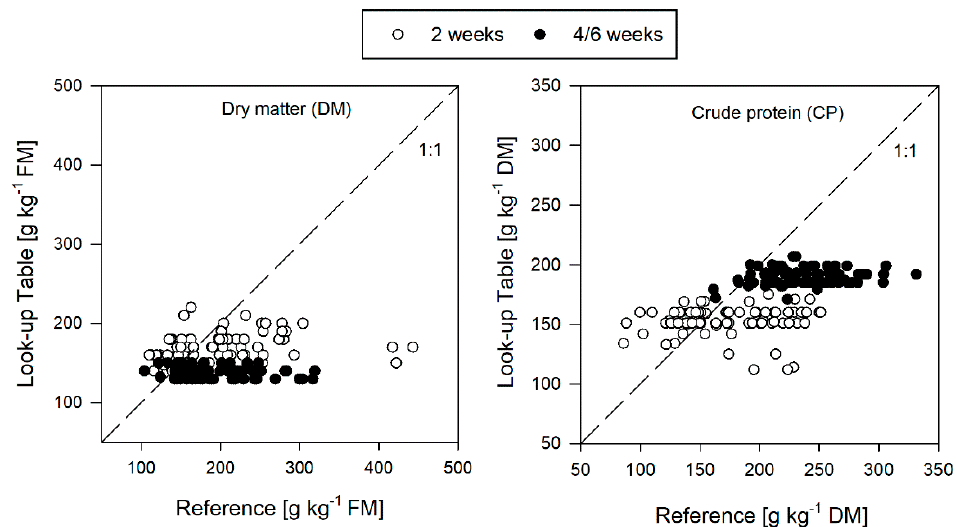
Figure 6. Herbage quality parameters determined with the Look-up Tables by Daccord et al. [10] versus the reference measurements ( n = 162). The dashed line is the line of identity (1:1). The open and filled dots represent the two growth stages of the plants: two weeks and four to six weeks of growth. Table 4. Disagreement (mean ± standard deviation) of Look-up Tables, On-site NIRS, and MSI-model with the reference methods (oven-drying and laboratory NIRS; n = 162).